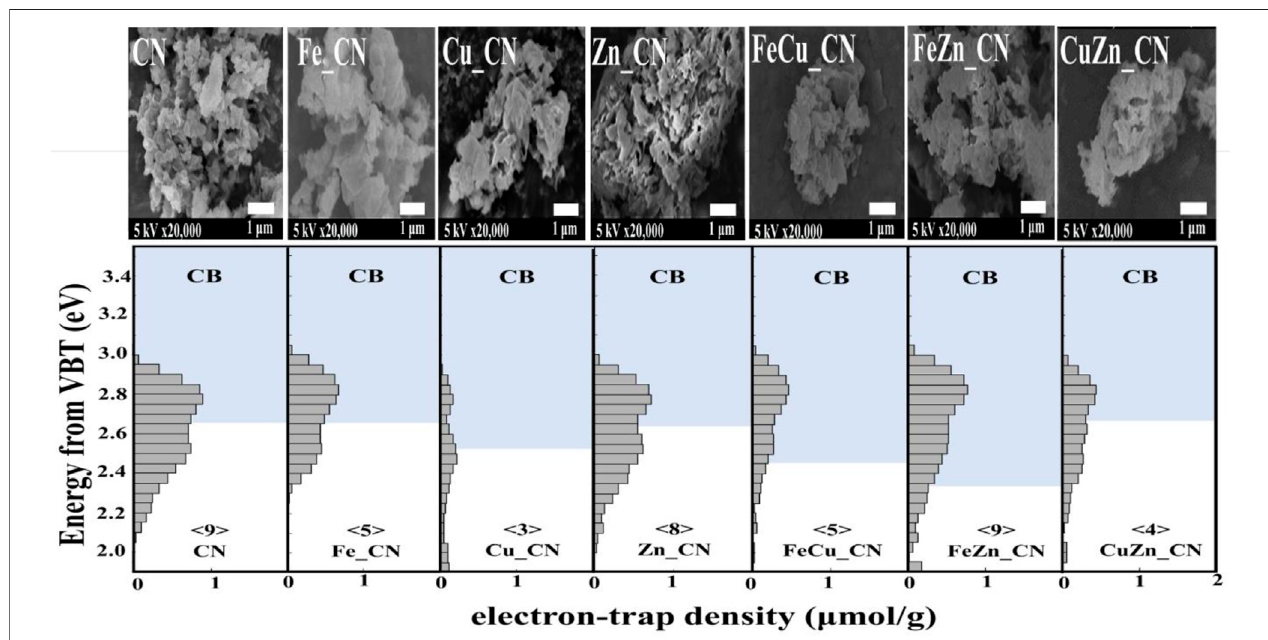
FIGURE6| ERDTpatternswithCBBpositionsofCNandmetal-dopedCNsamples.Thenumberin <> denotesthetotaldensityofETs,withtheunitsof μ mol g − 1 . VBT, valence band